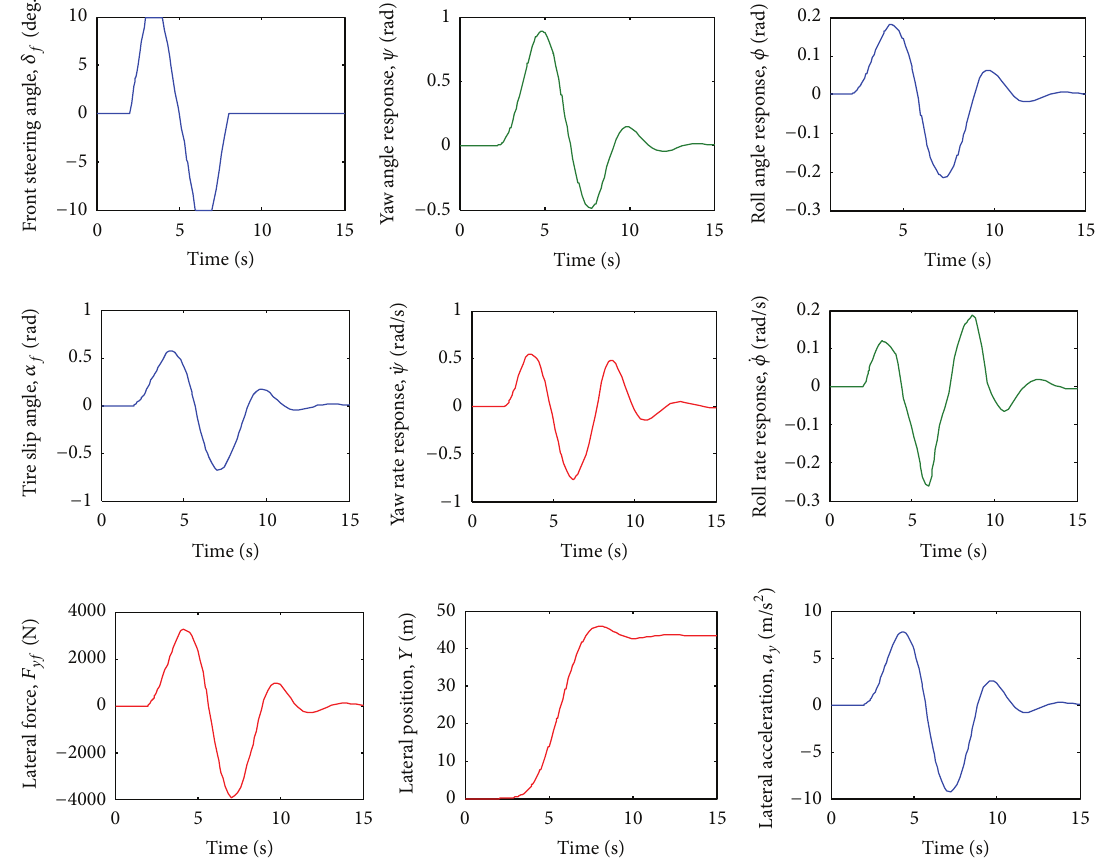
Figure 7: Vehicle manoeuvre test of single-lane change at 30 ms −1 with 𝜇 = 0.1 . Table 2: Model predictive control